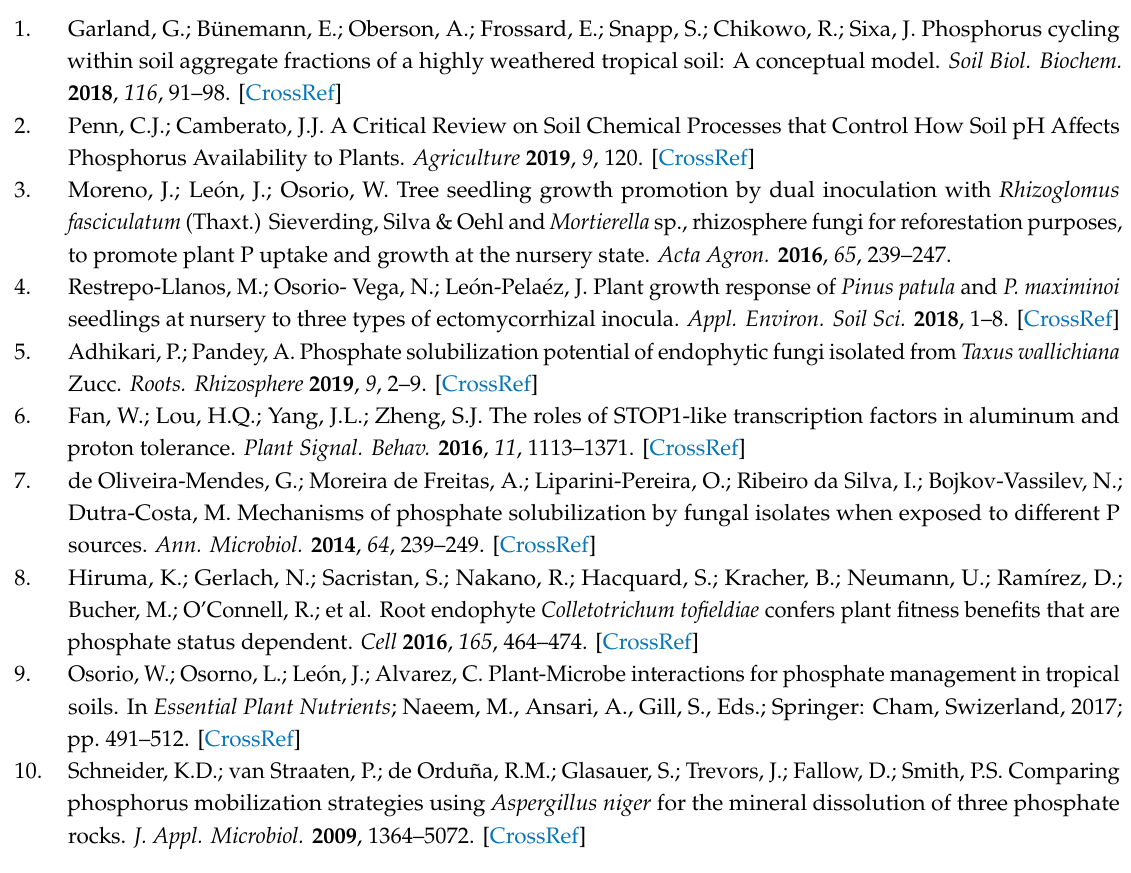
Figure S1: Whole phylogenetic reconstruction of the fungal strains characterized in this study. Table S1: Georeferencing and physicochemical characteristics of the studied soils; Table S2: Detection of the type and concentration of OAs in di ff erent soils with di ff erent strains; Table S3: Coe ffi cient of correlation and percentage of contribution of each variable (OAs) to the total length of the PC1 and PC2; Table S4: GLM table of the e ff ect of soil type factors and microorganisms on phosphorus, having PC 1 and PC2 as